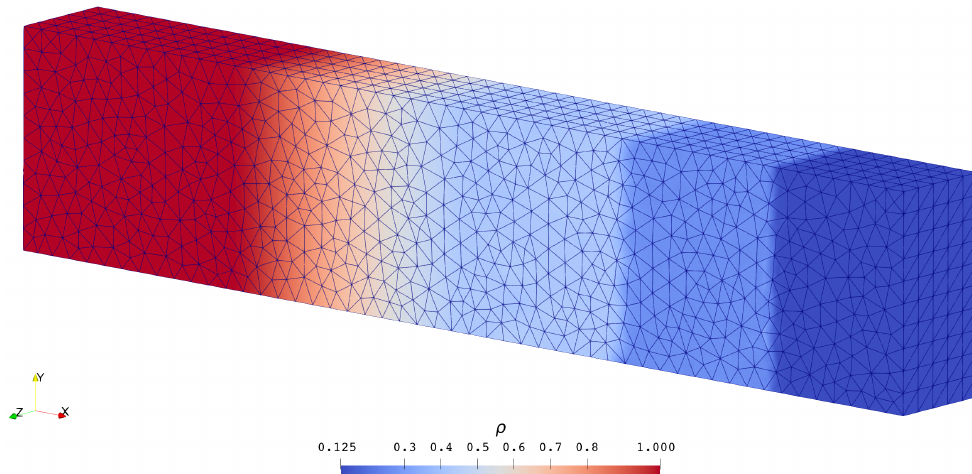
Figure 1. Third-order solution of ρ ( t = 1.0 ) in Problem 1.